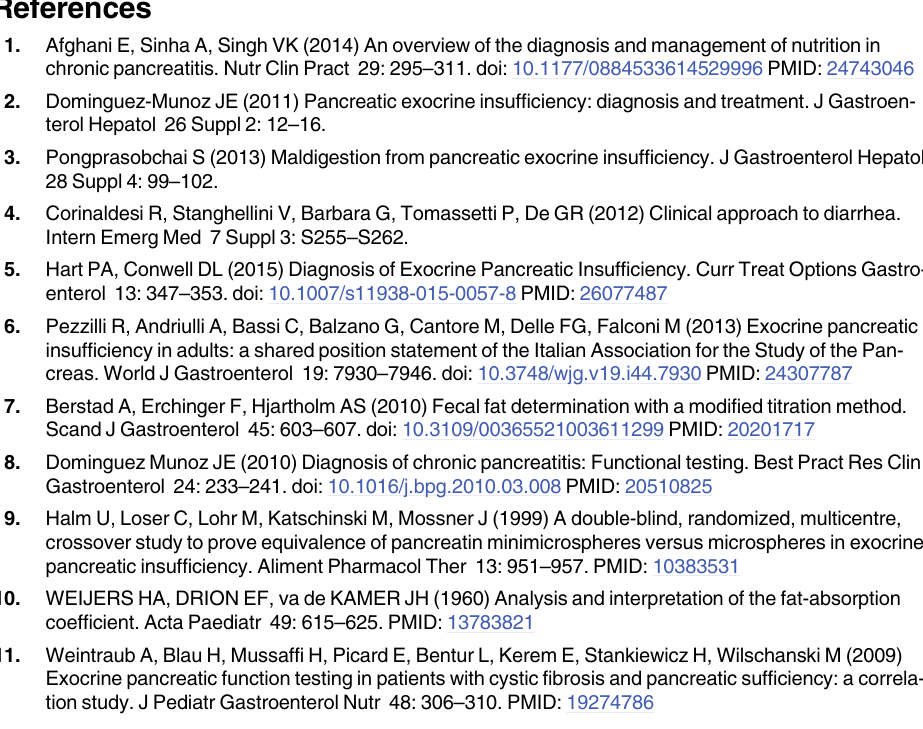
S1 Table. Patient groups, original